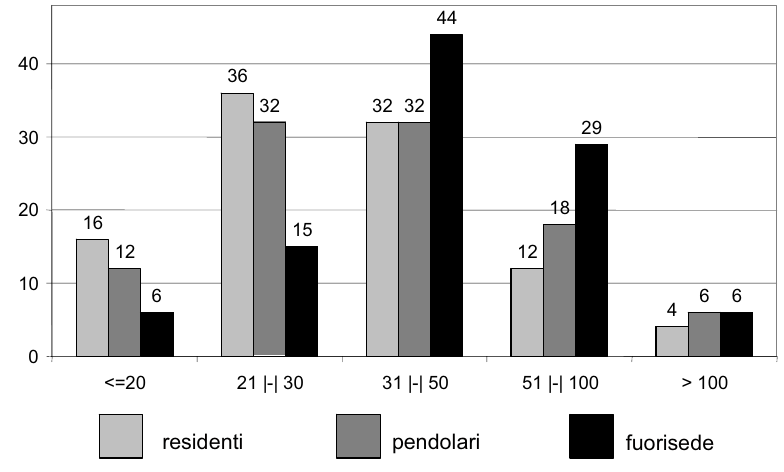
Figura 1 – Distribuzione percentuale degli studenti in base alla spesa media settimanale per studio, cultura, svago e tempo